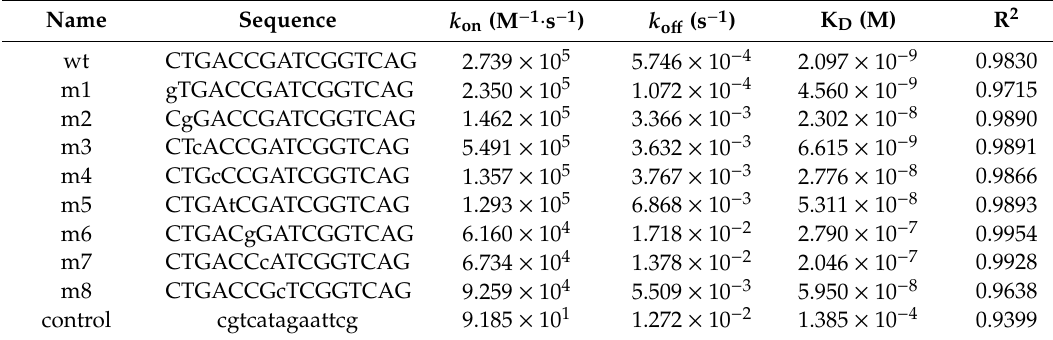
Table 1. TTHB023-DNA binding parameters.